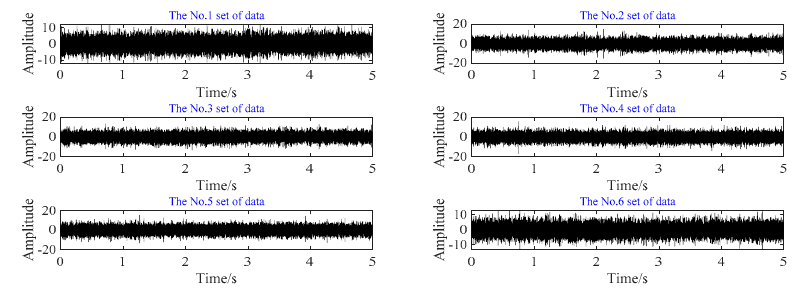
Figure 15. Sectional time domain diagram of outer ring fault.